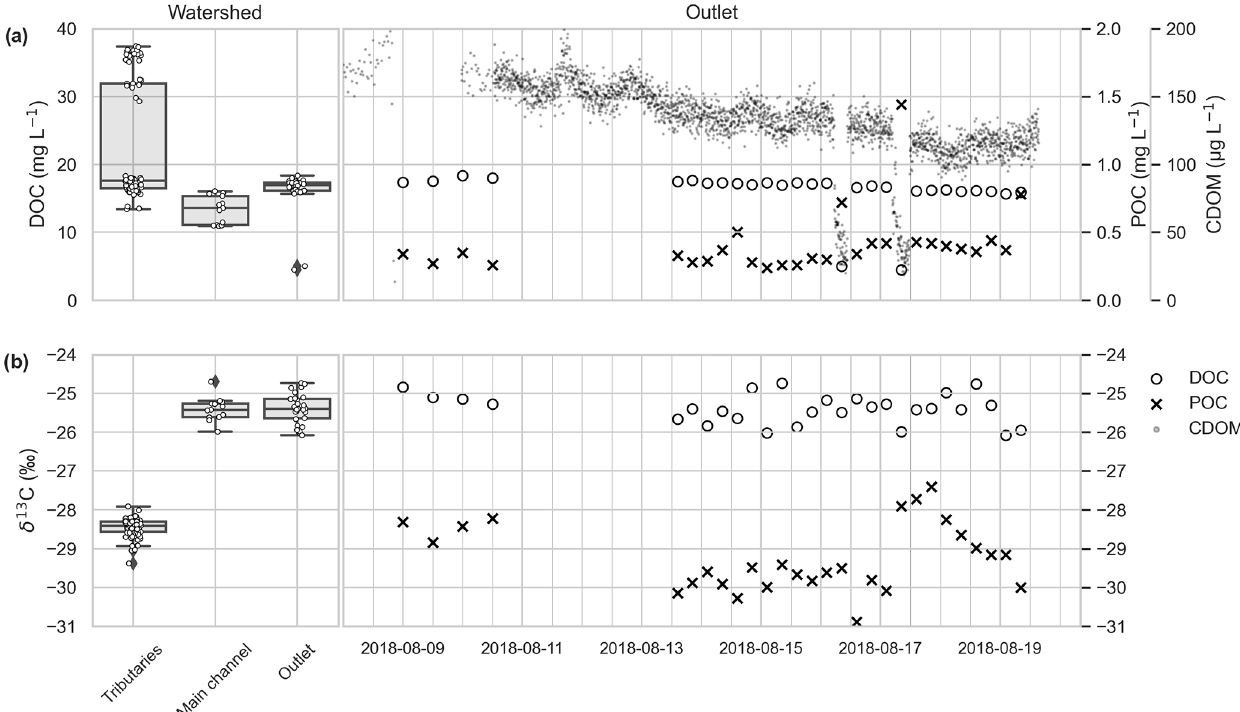
Figure 3. DOC concentrations (mgL − 1 ) measured within tributaries, the main channel and the outlet ( a , left) and POC (mgL − 1 ; cross mark- ers), DOC (mgL − 1 ; circles; please note that the scale on the left panel applies to the right panel as well) and CDOM (mgL − 1 ; filled small circles) concentrations within stream water at the watershed outlet over time ( a , right). δ 13 C DOC isotopic signal within tributaries, the main channel and the outlet ( b , left) and δ 13 C DOC and δ 13 C POC over time at the catchment outlet ( b , right). Note that two clear drops in the CDOM measurements on 16 and 17 August mark a storm event. This is also visible in the δ 13 C POC and to lesser extent δ 13 C DOC source shift ( b , right) around these dates. Please note that the date format used in this figure is year-month-day. Table 3. δ 13 C values of DOC and POC/SOC for various sources in the catchment. Source δ 13 C DOC δ 13 C SOC/POC b δ 13 C difference (mean ± SD) (mean ± SD) HCP